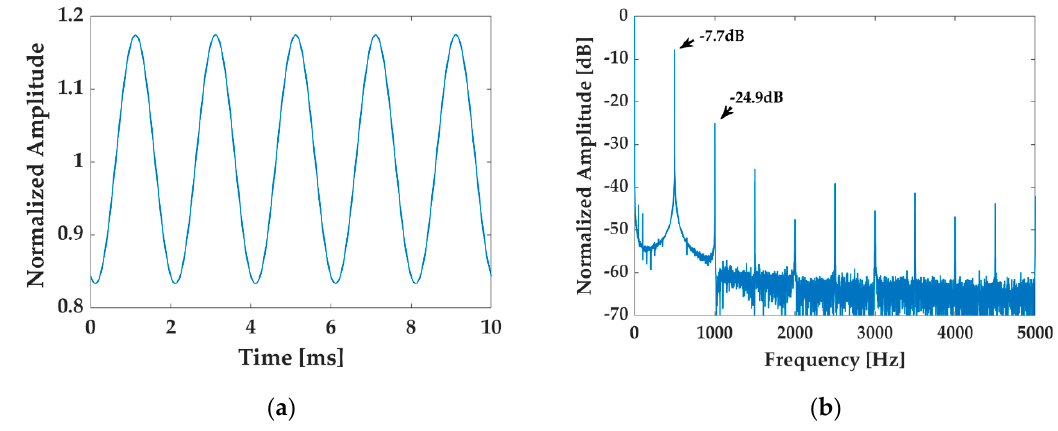
Figure 4. Normalized results of the light source output. ( a ) The time-domain waveform; ( b ) the logarithmic frequency spectrum.